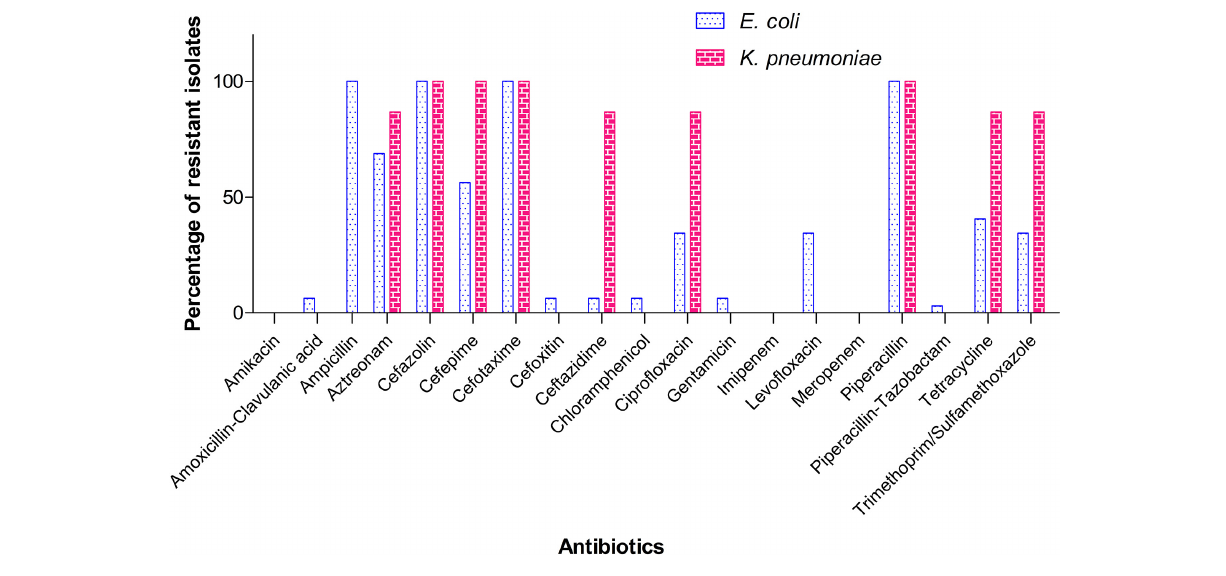
(MIC ≥ 16 µ g/ml). Percentage of resistance among E. coli